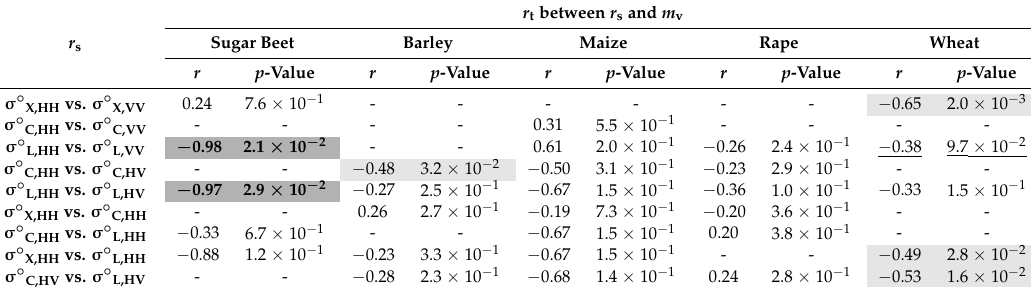
Table 9. r t vs. m v temporal correlations, r t , over the whole period for different crops; significant correlations ( p -value < 0.05) are in light-gray highlighted; strong (0.6 < r < 0.8) significant correlations are also bolded; very strong ( r > 0.8) significant correlations are also highlighted in dark-gray; quasi -significant correlations (0.05 < p -value < 0.1) are outlined; very weak correlations ( r < 0.19) are not reported.